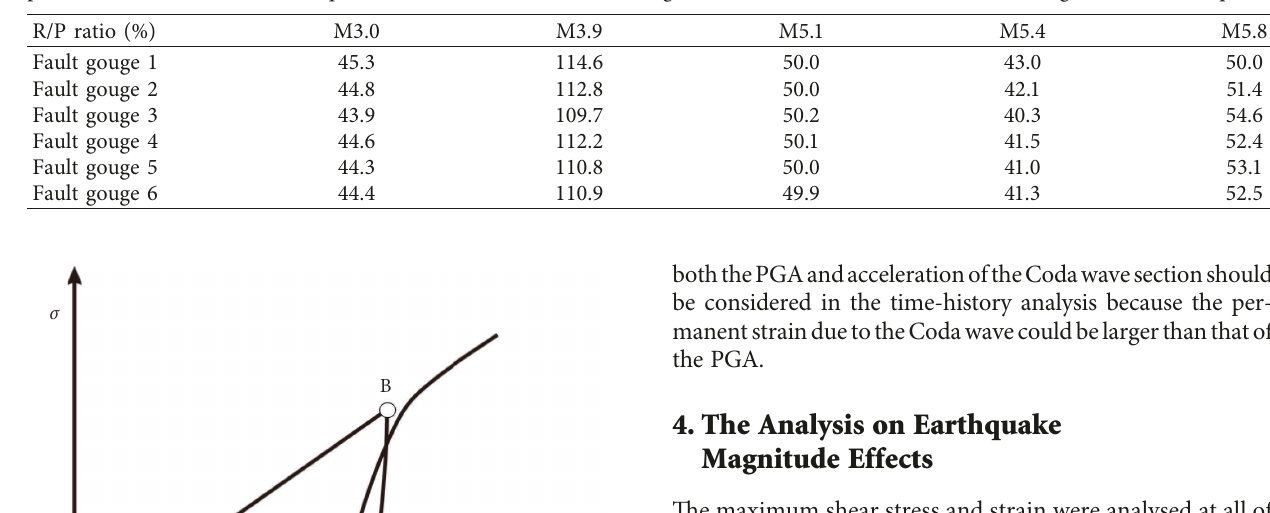
Table 4: Residual shear stress (or strain)/peak (maximum) shear stress (or strain) ratio of each fault gouge and earthquake in the model. The R/P ratio is approximately 40%–55% for each earthquake, with the exception of the M3.9 earthquake. This means that ground has some permanent strain after the earthquake. The residual shear strain is higher than the maximum shear strain during the M3.9 earthquake.